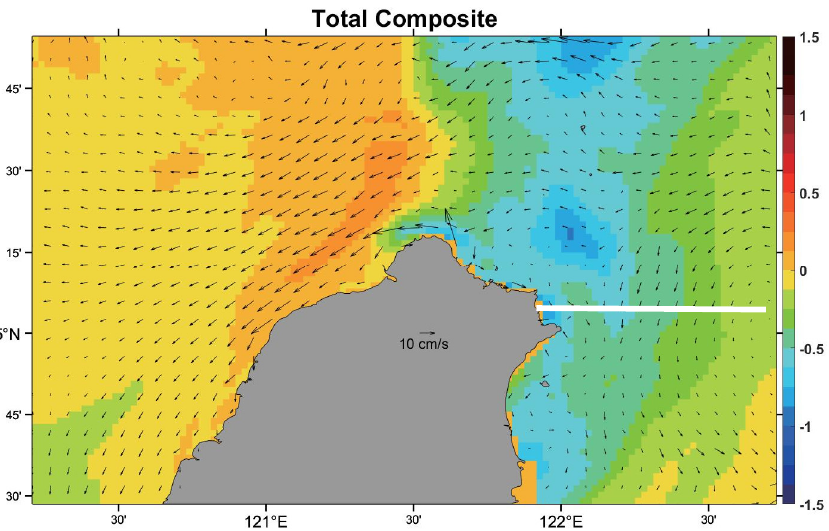
Figure 10. Depth-averaged tidal residual currents (arrows) superimposed on tidal residual SST (color shadings). This figure shows the composite of typhoons. The thick white segment denotes a shore-normal transect corresponding to Figure 11.